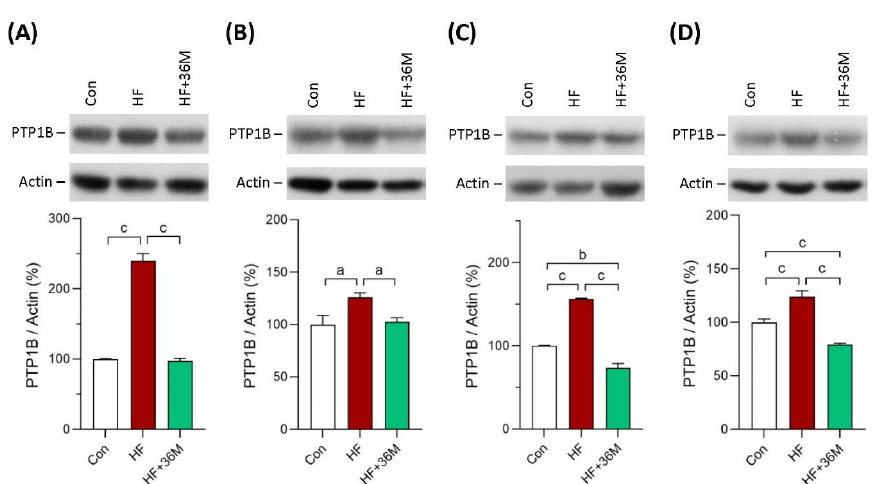
Figure 10. Protein expression of PTP1B. ( A ) PTP1B expression in skeletal muscle of the mice in the prevention model. ( B ) PTP1B expression in skeletal muscle of the mice in the treatment model. ( C ) PTP1B expression in liver of the mice in the prevention model. ( D ) PTP1B expression in liver of the mice in the treatment. Bar charts are the quantified results of the immunoblots. These protein expressions were detected by Western blotting. Con: control; HF: high-fat diet. Data are mean ± SE (n = 8). a: p < 0.05; b: p < 0.01; c: p < 0.001.